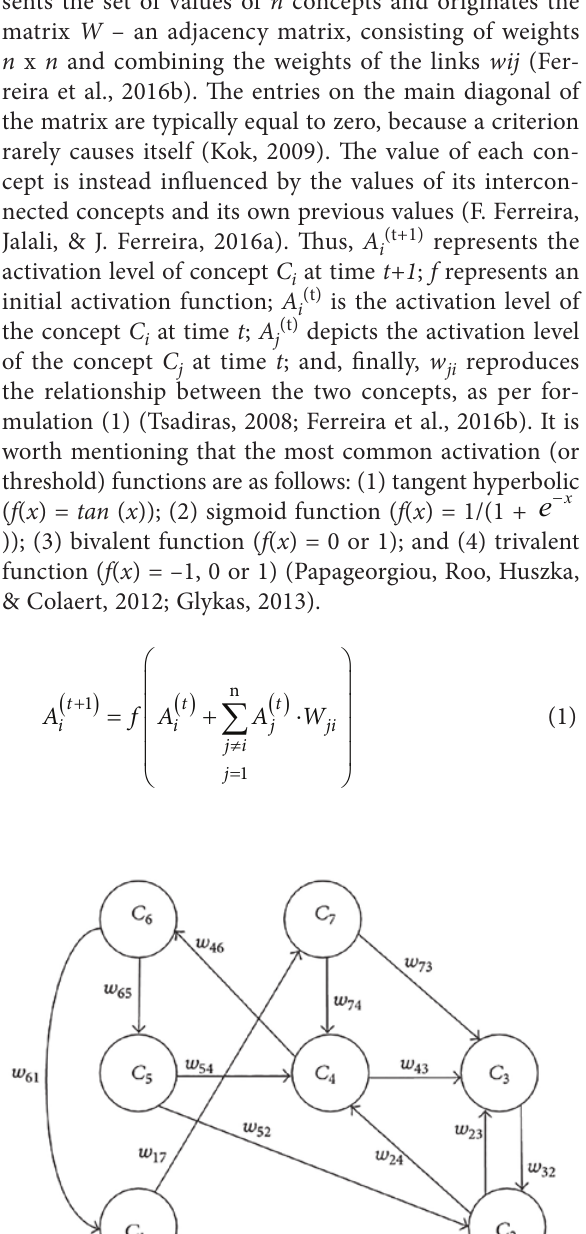
Figure 1 exemplifies an FCM.